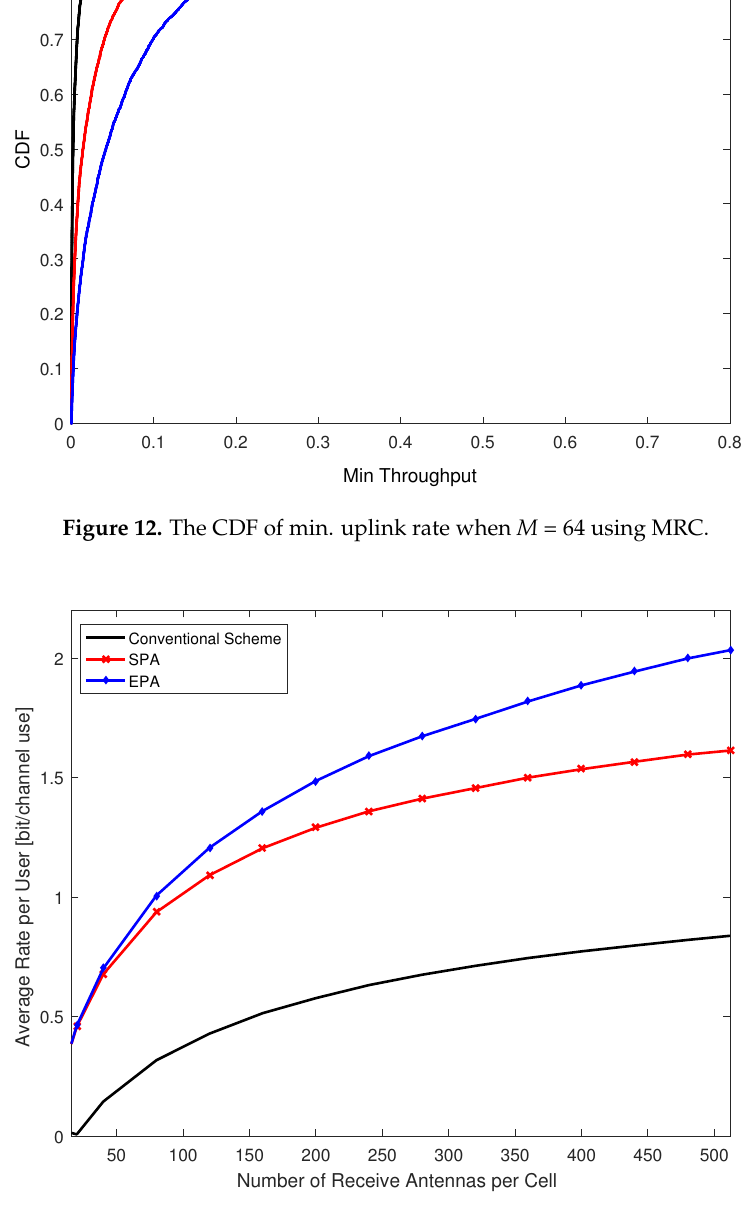
Figure 13. The average uplink rate per user with ZF for different numbers of antennas, K = 20 , and R = 300